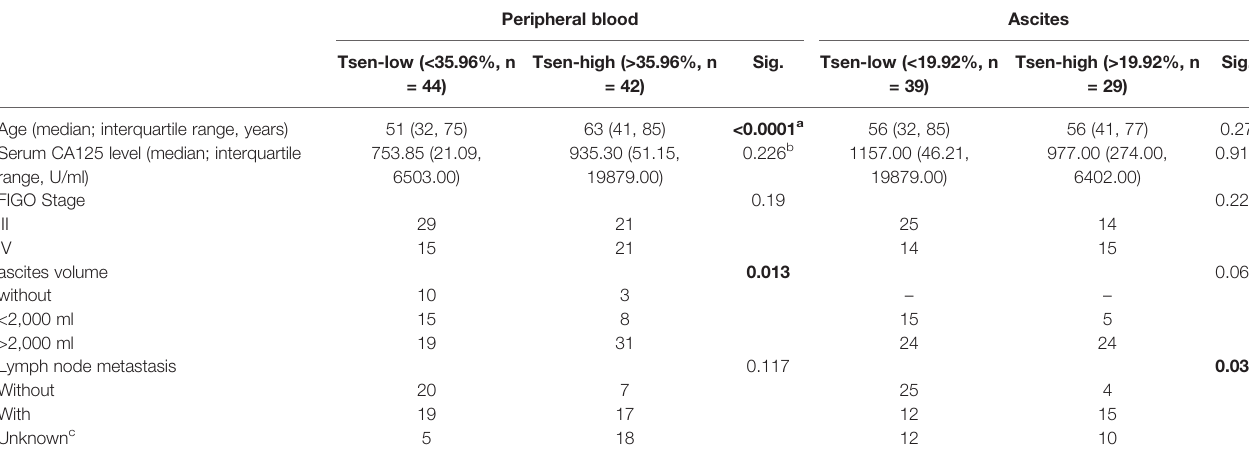
TABLE 3 | Clinical characteristics difference of patients with high/low levels of Tsen CD8 + T cells.